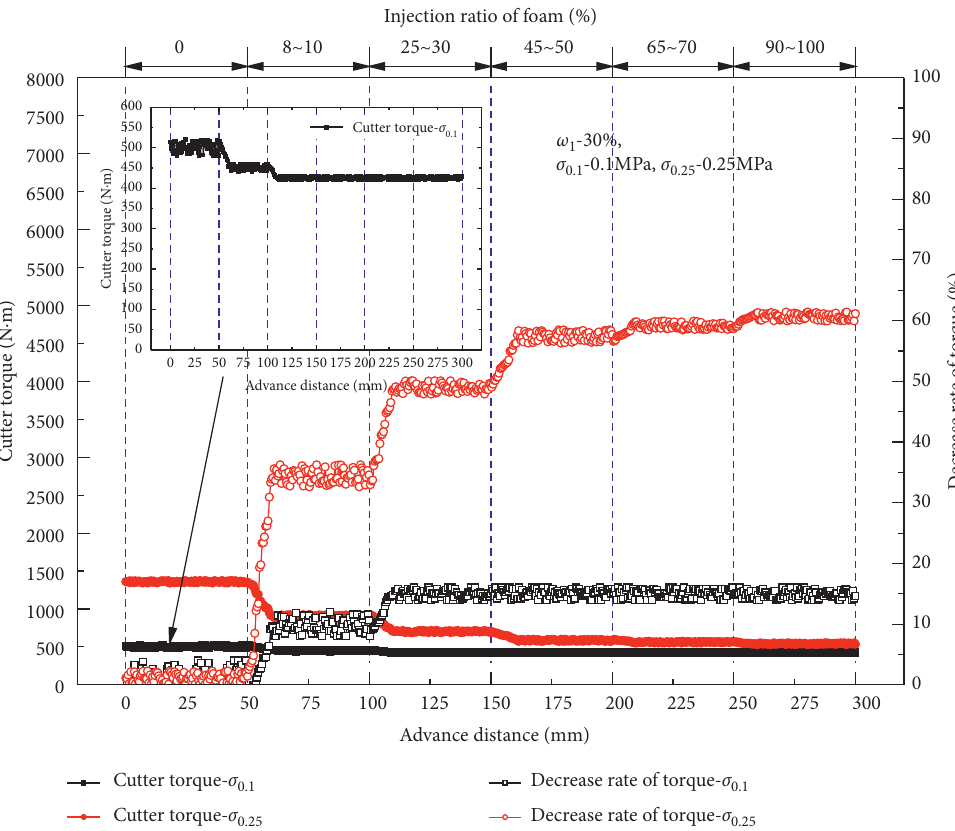
Figure 23: Effect of foam conditioning and soil pressure on cutter torque at water content